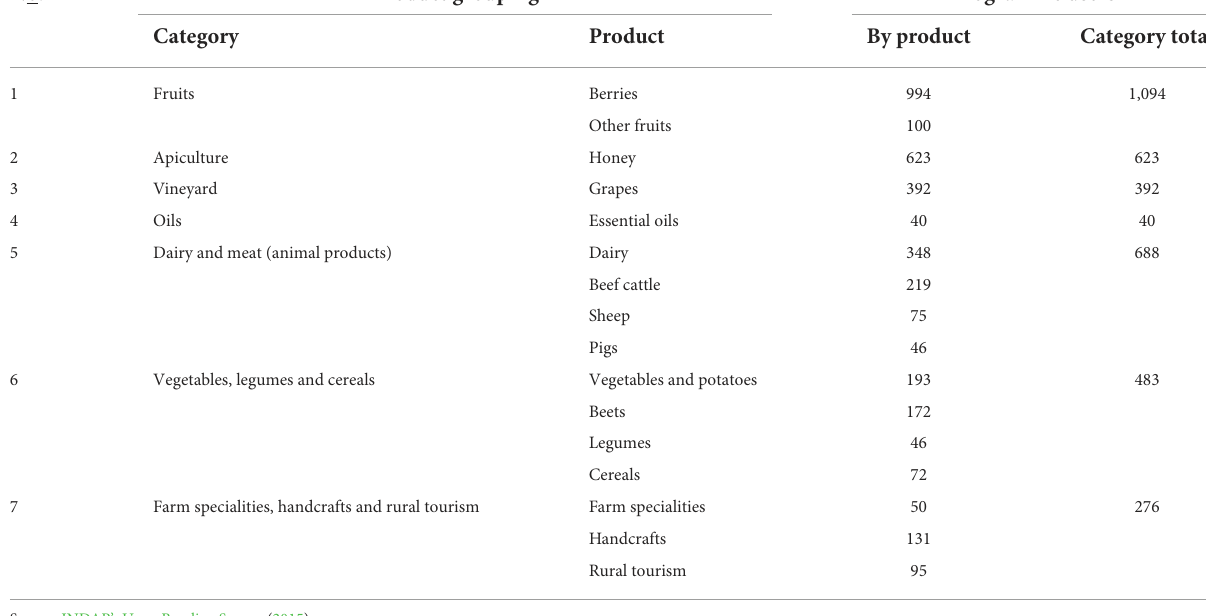
TABLE 2 PAP participants by product and product category.